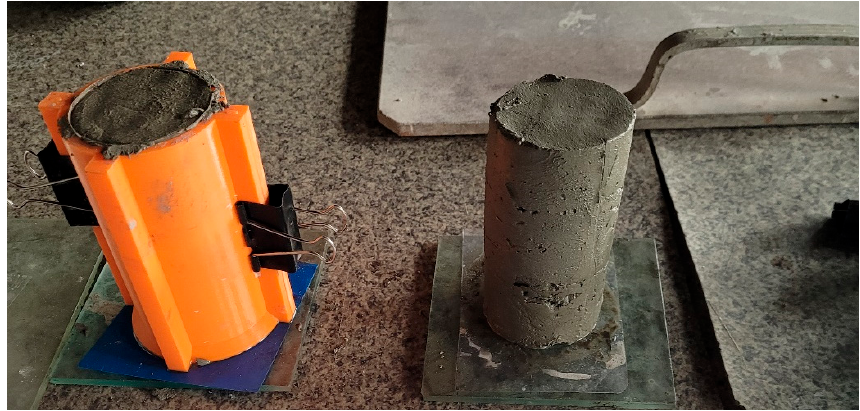
Figure 6. Molding of samples.